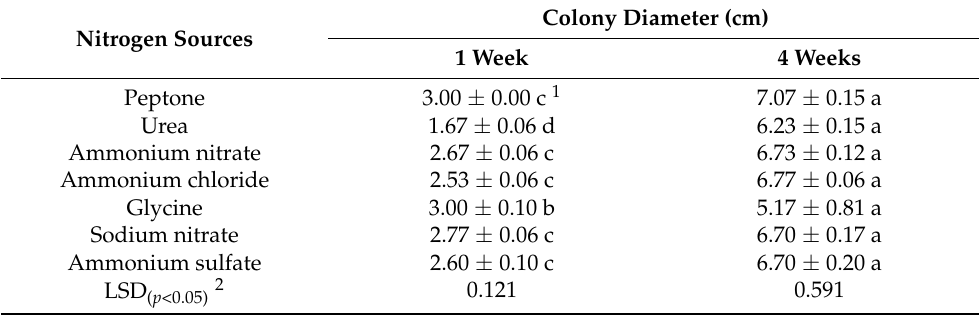
Table 4. Mean ( ± SEM) colony diameter of Paraphoma radicina on seven different nitrogen sources grown at L:D 0:24 h and 25 ◦ C, measured one and four weeks after